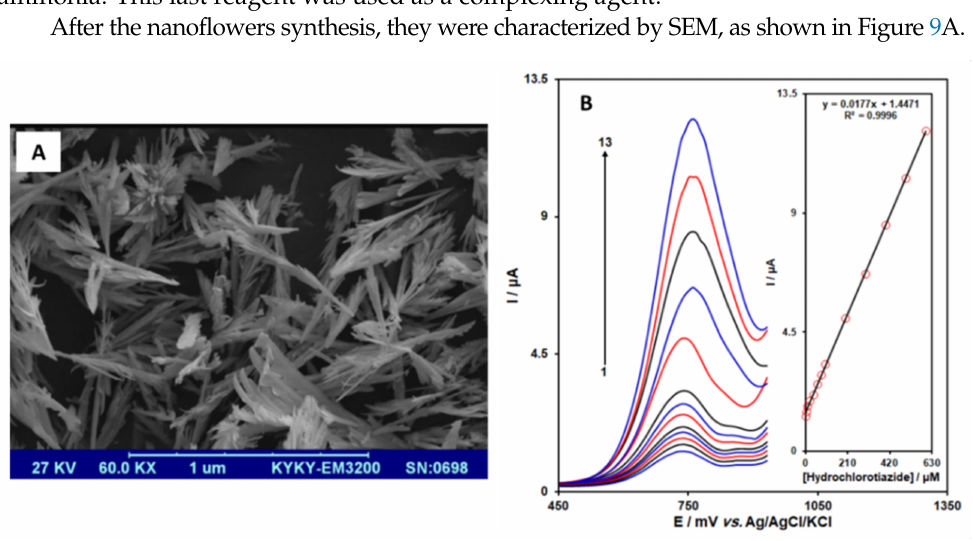
Figure 9. ( A ) SEM micrograph of La 3+ -doped ZnO nanoflowers. ( B ) Differential pulse voltammo- grams obtained for the La 3+ /ZnO/SPE in the presence of different concentrations ranging from 1 to 600 µ M of hydrochlorothiazide. Inset figure corresponds to the calibration plot for the HCT determination. Reproduced with permission of Rezaei et al., International Journal of Electrochemical Science; published by ESG, 2019